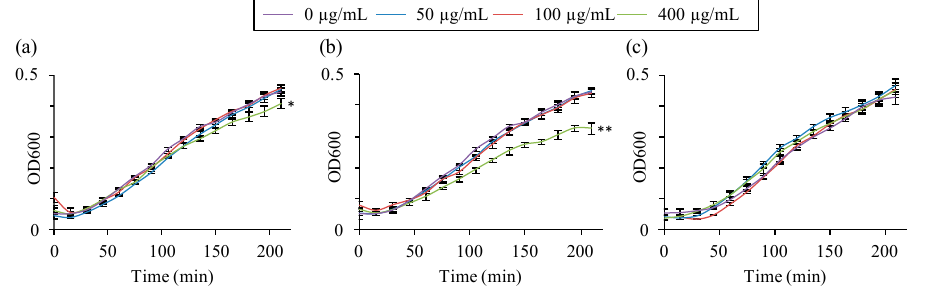
Figure 7. Quantification of the growth of E. coli bacteria during 3.5 h of exposure to increasing concentrations of ( a ) as-synthesized Na-X; ( b ) fluorinated F-X; and ( c ) cerium ion exchanged Ce-X zeolites. Bacterial growth was assessed by measuring the optical density (OD 600 ). Mean ± SD, n = 3.